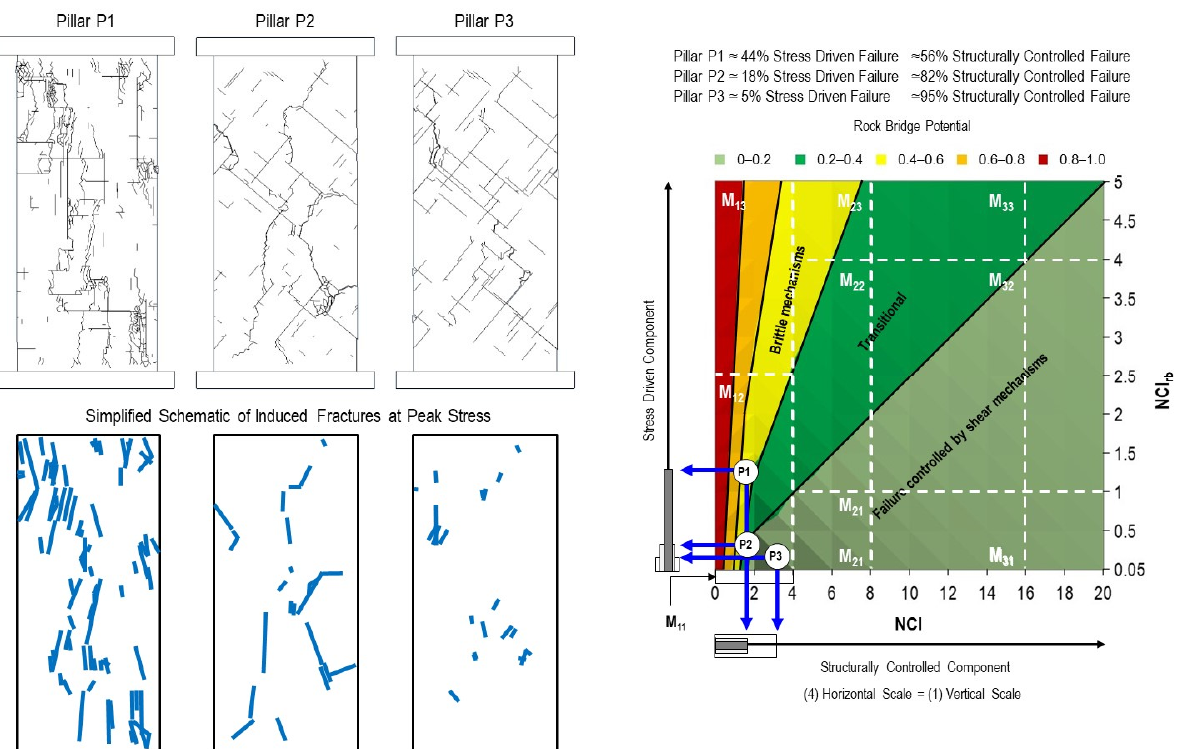
Figure 11. Concept of rock bridge potential applied to study the behaviour of jointed pillars (8 m high, 4 m wide). Modelling results were published in [27]. high, 4 m wide). Modelling results were published in